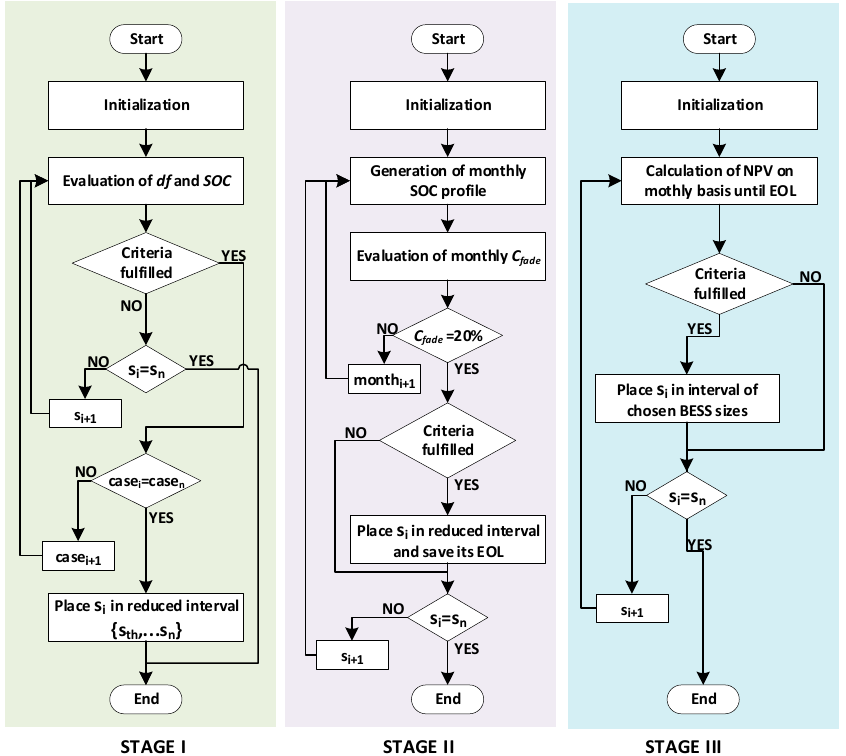
Figure 7. Flowchart of each stage of the proposed methodology.